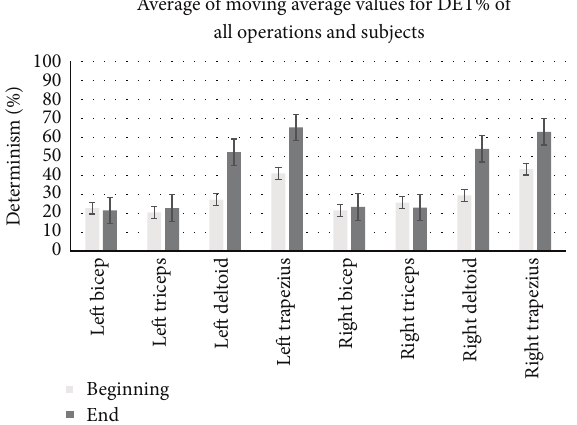
Figure 5: Average of moving average values for DET% of all the operations and subjects for the beginning and end of